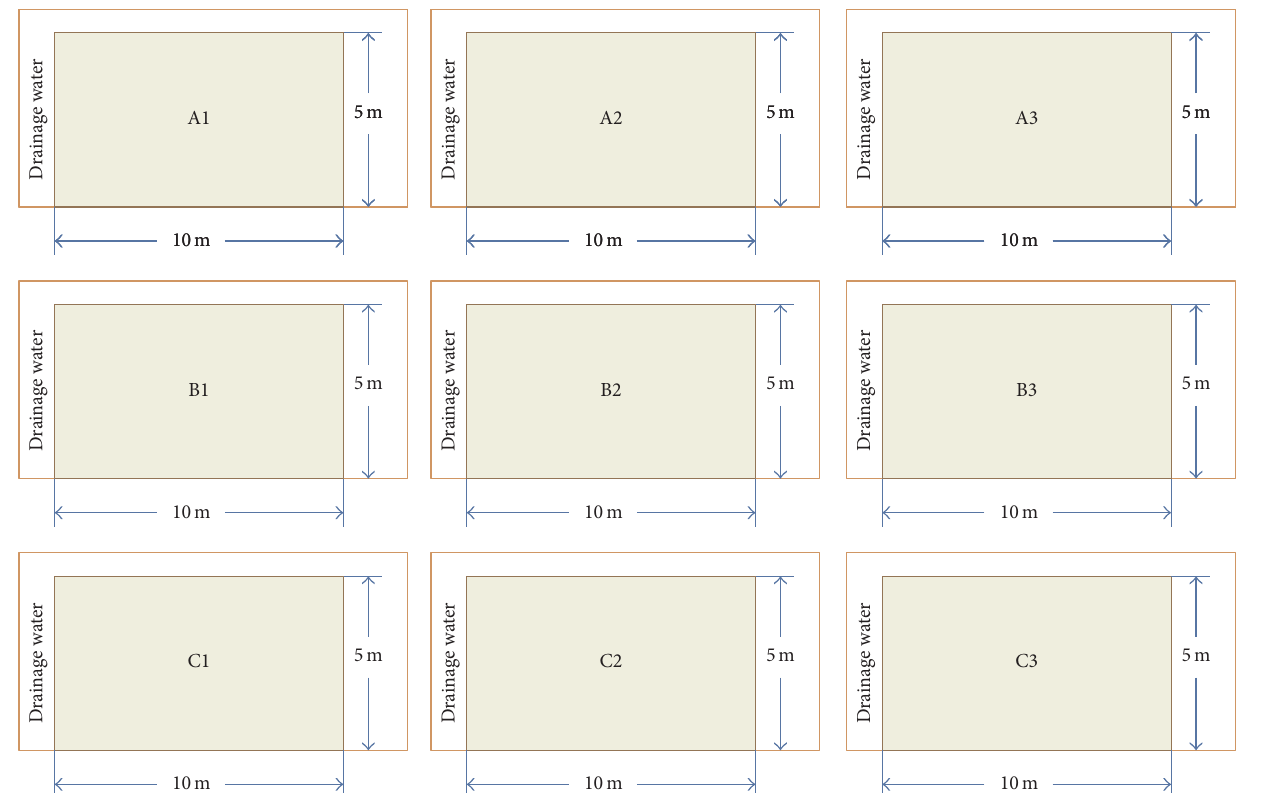
Figure 1: Layout of the experimental fields: treatment A (A1–A3), treatment B (B1–B3), and treatment C (C1–C3).